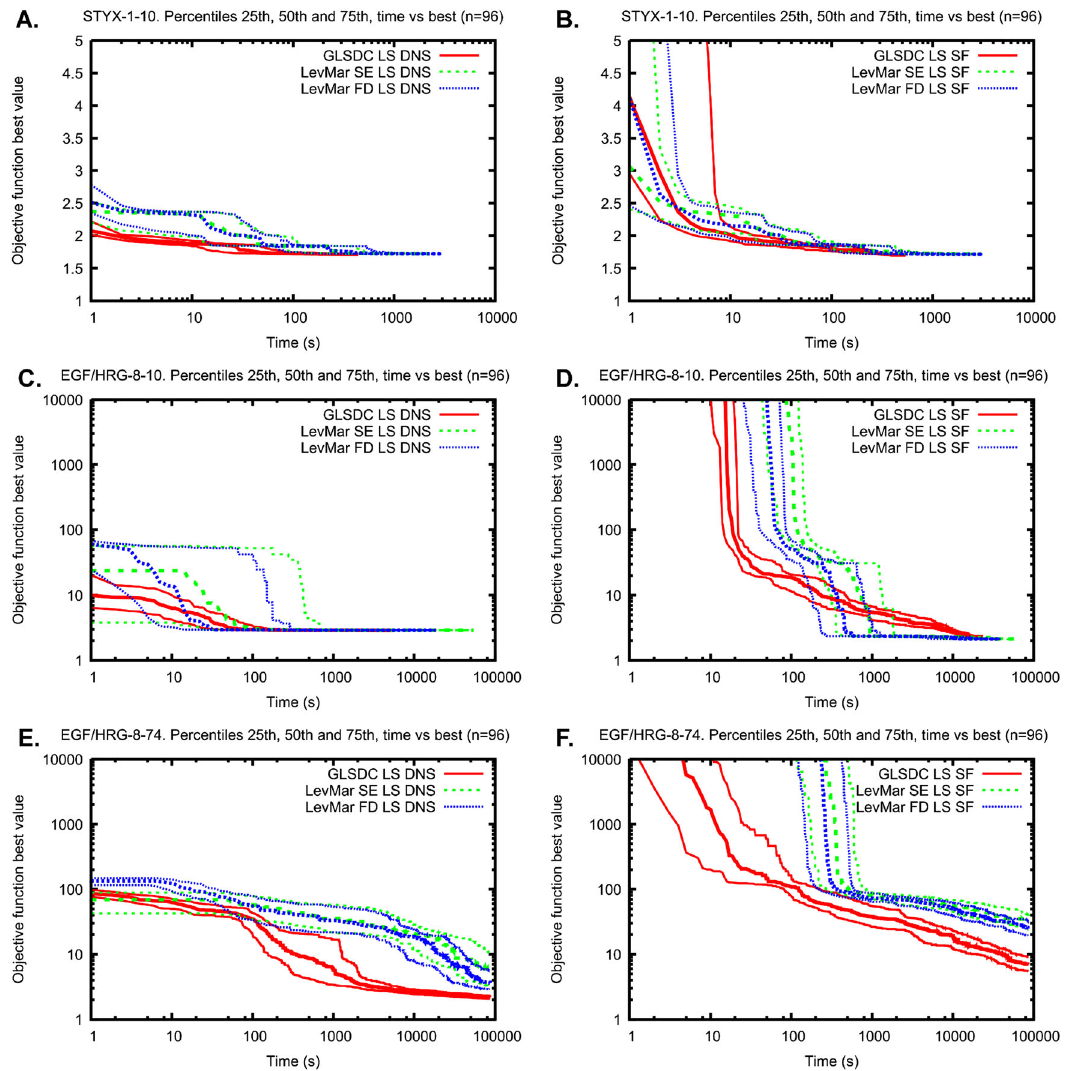
Fig. 4 Convergence of the three optimisation algorithms for a , b the STYX-1-10 problem, c , d the EGF/HRG-8-10 problem and e , f the EGF/HRG-8-74 problem. The plots show the median ( thick line ), and 25th and 75th percentiles ( thin lines ) of the objective function minima (least squares values) over the computation time from independent 96 runs. a , c , e Normalisation of the simulations ( DNSs ). b , d , f Scaling factors ( SFs